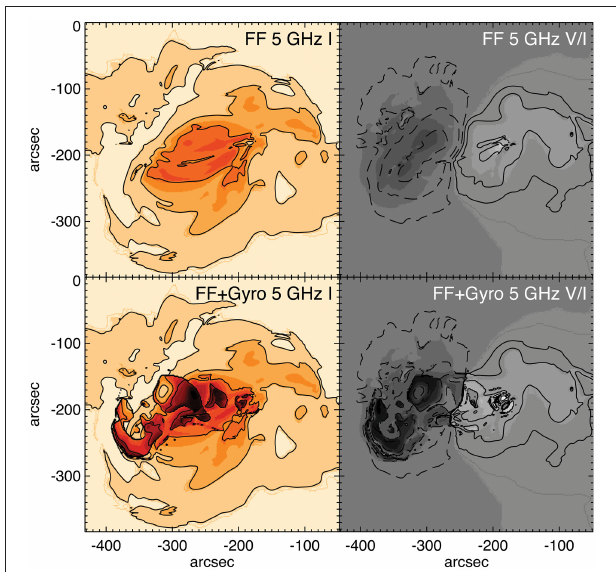
FIGURE 8 | Radio emission from a model active region comparing calculations with and without gyroresonance emission. Thermal bremstrahllung or free–free emission (“FF”) is included in both cases. Total intensity (Stokes I ) is plotted in the left panels and degree of polarization ( V / I , scaled from 1 to 1) is plotted in the grayscale in the right panels, with − contours showing Stokes V . The brightness temperature display range in the left–hand panels is 0 to 2.5 10 6 K. Contour levels are at 16, 32, 64, 128, × and 256 10 4 K in the Stokes I panels, and 1, 4, 16, and 64 10 4 K in the × × V / I images. The pixel size is 1.5